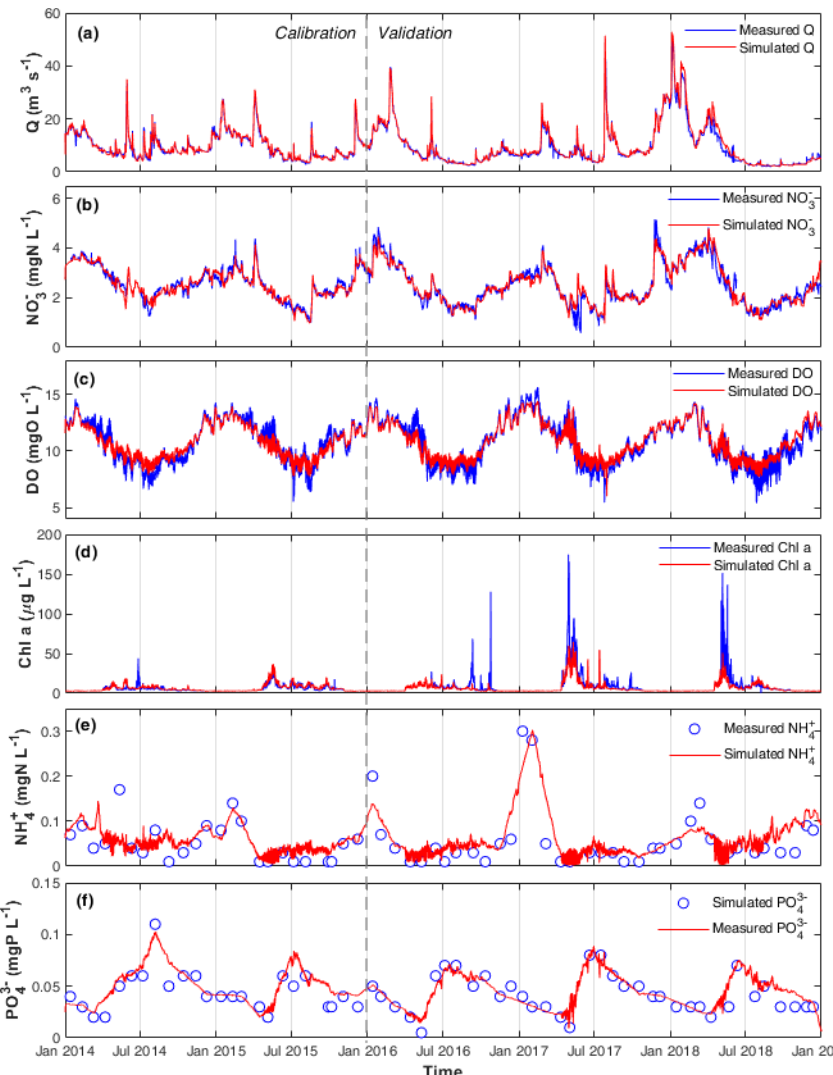
Figure 2. Measured and simulated (a) Q , (b) NO − periods at the STF